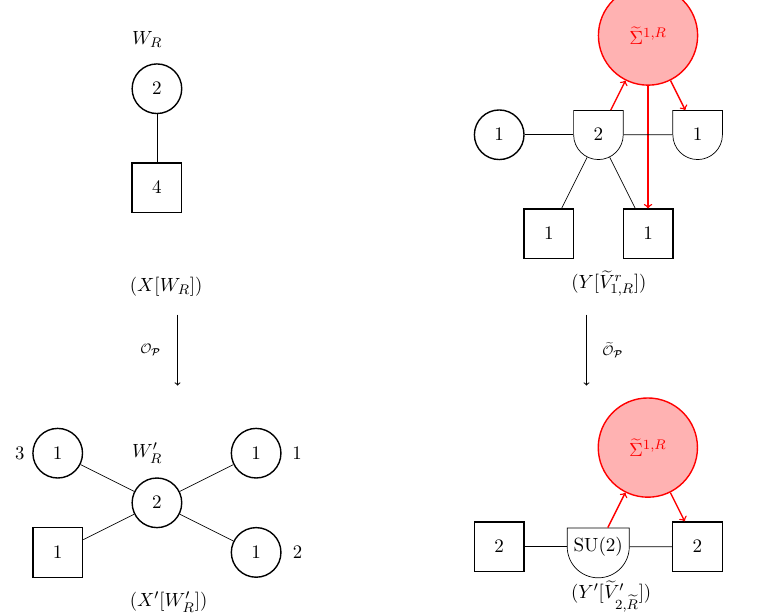
Figure 34 . The construction of a Wilson defect in a flavored D 4 quiver gauge theory and its dual vortex defect, using an Abelian gauging operation.